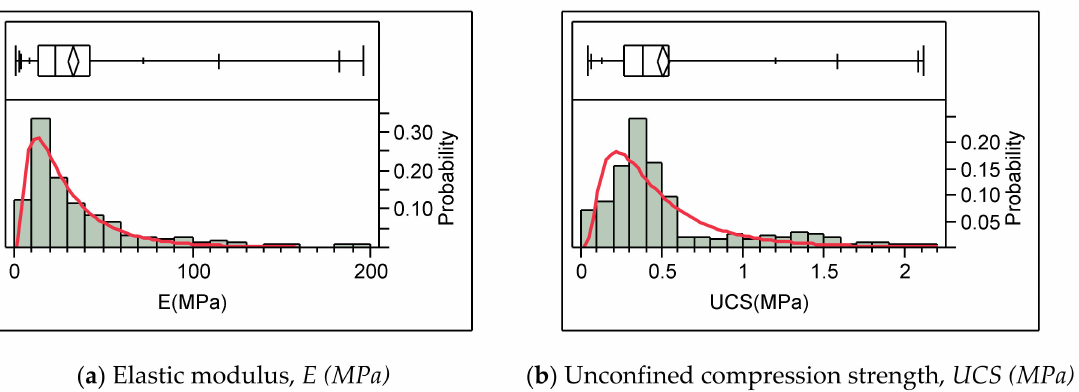
Figure 9. Relative frequency histograms and lognormal fits of response variables ( a ) Elastic Modulus (E), and ( b ) Unconfined Compression Strength ( UCS